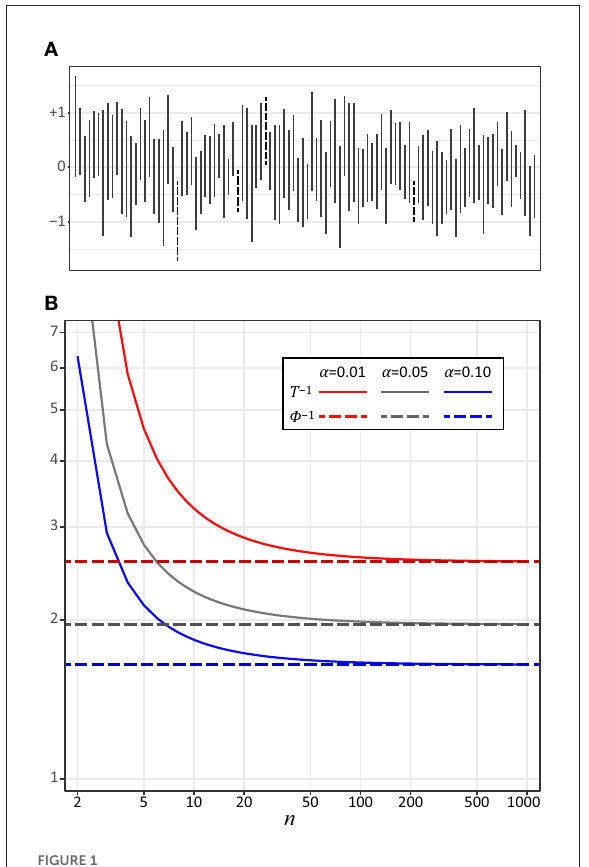
FIGURE1 (A) The 95% CIs of the mean of the standard normal distribution computed from 100 sessions of a computer simulation. In each session of simulation, 10 samples were taken from a standard normal distribution and the CI was computed from samples based on a t -distribution (see Equation 1). The CIs that do not include the mean (0) are dotted. (B) The inverse cumulative distribution function T − 1 of the t -distribution plotted as a function of the sample size n . The colors show the levels of α ( α 0.01, 0.05, and 0.10 for the 99, 95, and 90% CIs). The values of = the inverse cumulative distribution function Φ − 1 of the standard normal distribution are 2.58, 1.96, and 1.64 with α and 0.10, respectively (shown in this graph as dashed